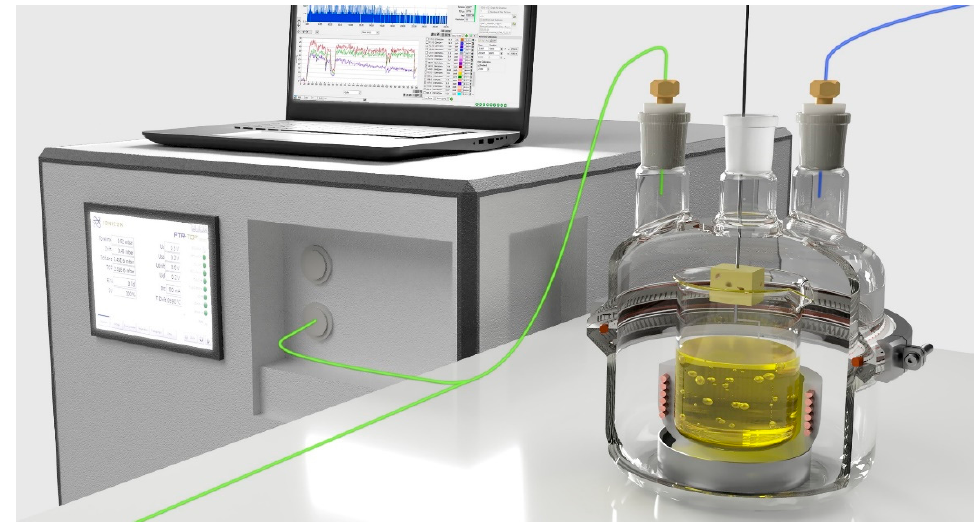
Figure 4. Experimental setup for early-stage SOPs (secondary oxidation products) monitoring.